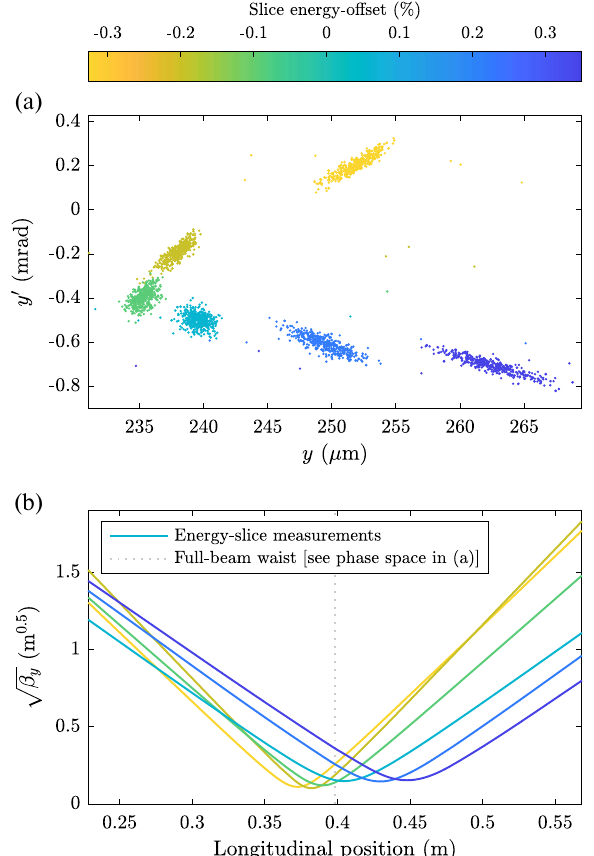
FIG. 7. Chromaticity measurement using an energy-slice scan. (a) Jitter phase space for a range of energy slices. Significant dispersion (energy-dependent offsets) can also be observed. Each step consists of 500 shots. (b) The corresponding evolution of the beta function for each slice in the focus region, indicating a highly chromatic